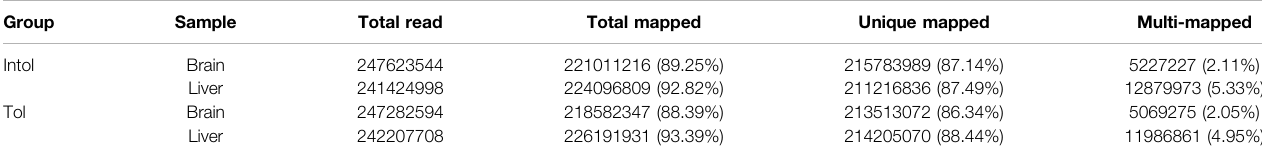
TABLE 1 | Statistical analysis of alignment results with reference genome. Group